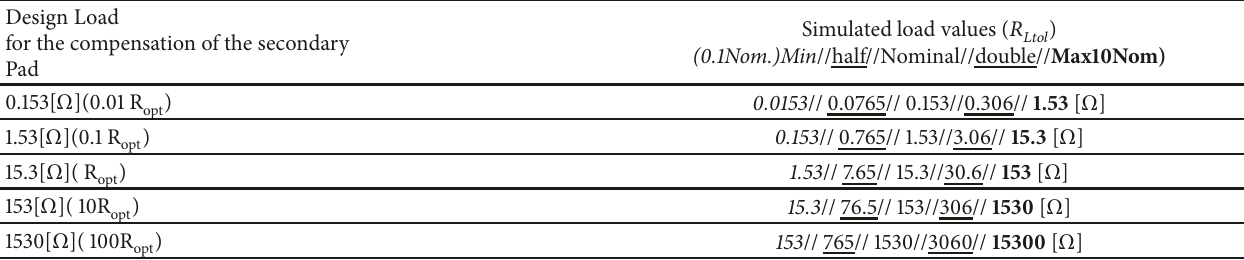
Table 6: Parameters of the simulated circuit with LCC